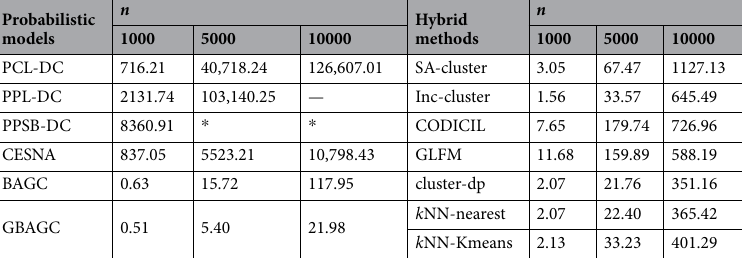
Table 7. Time cost of the compared algorithms (in seconds).